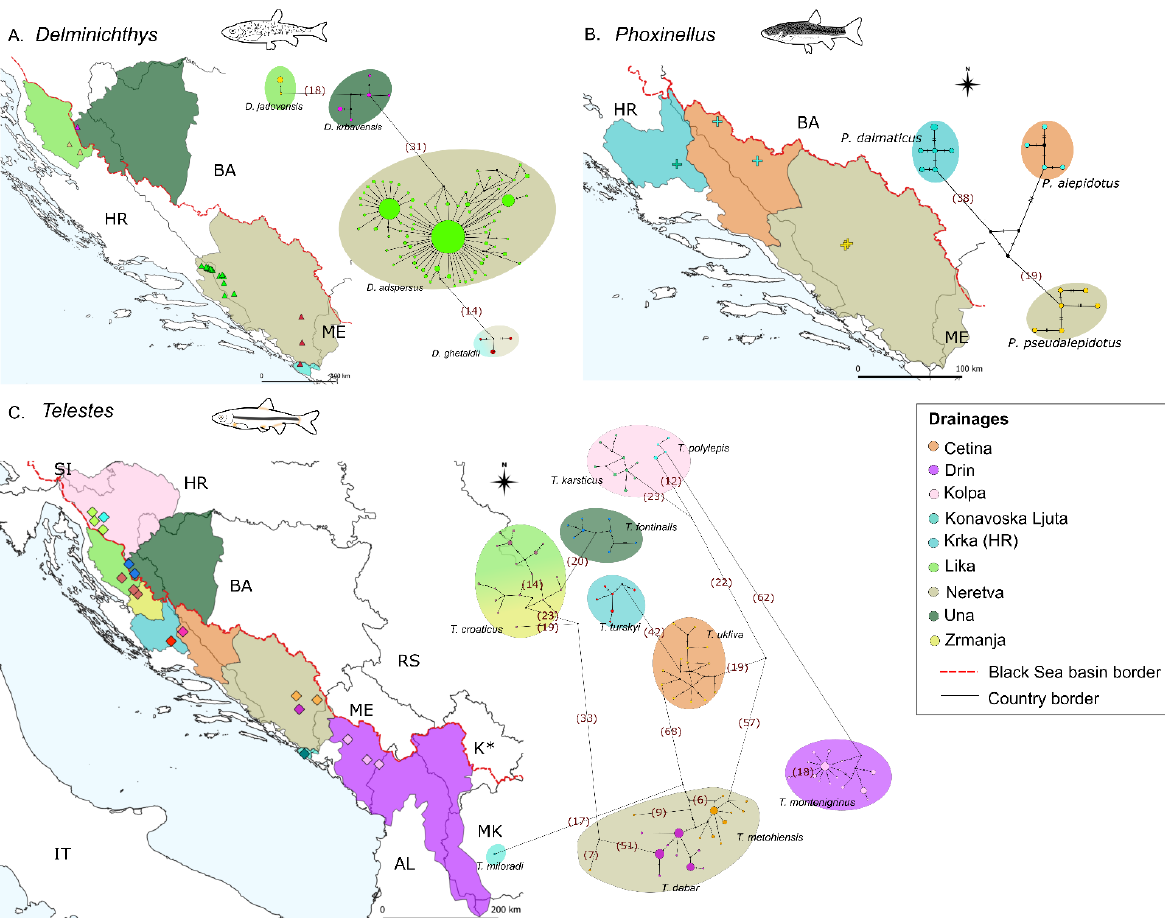
Figure 5. Distribution maps and haplotype networks (based on cytochrome b fragment) of mito- chondrial lineages, corresponding to species, of the three fish genera Delminichthys , Phoxinellus and Telestes within Dinaric Karst. The river drainages are represented by different colors (see legend) and the Adriatic–Black Sea basin divide is marked with a red dashed line. Mutational steps < 5 are given as dashes, mutational steps ≥ 5 are written in parentheses. Colors of haplotypes denote species. The ovals correspond to the drainage basin where each species occurs. ( A ) Delminichthys ; ( B ) Phoxinellus ; ( C ) Telestes